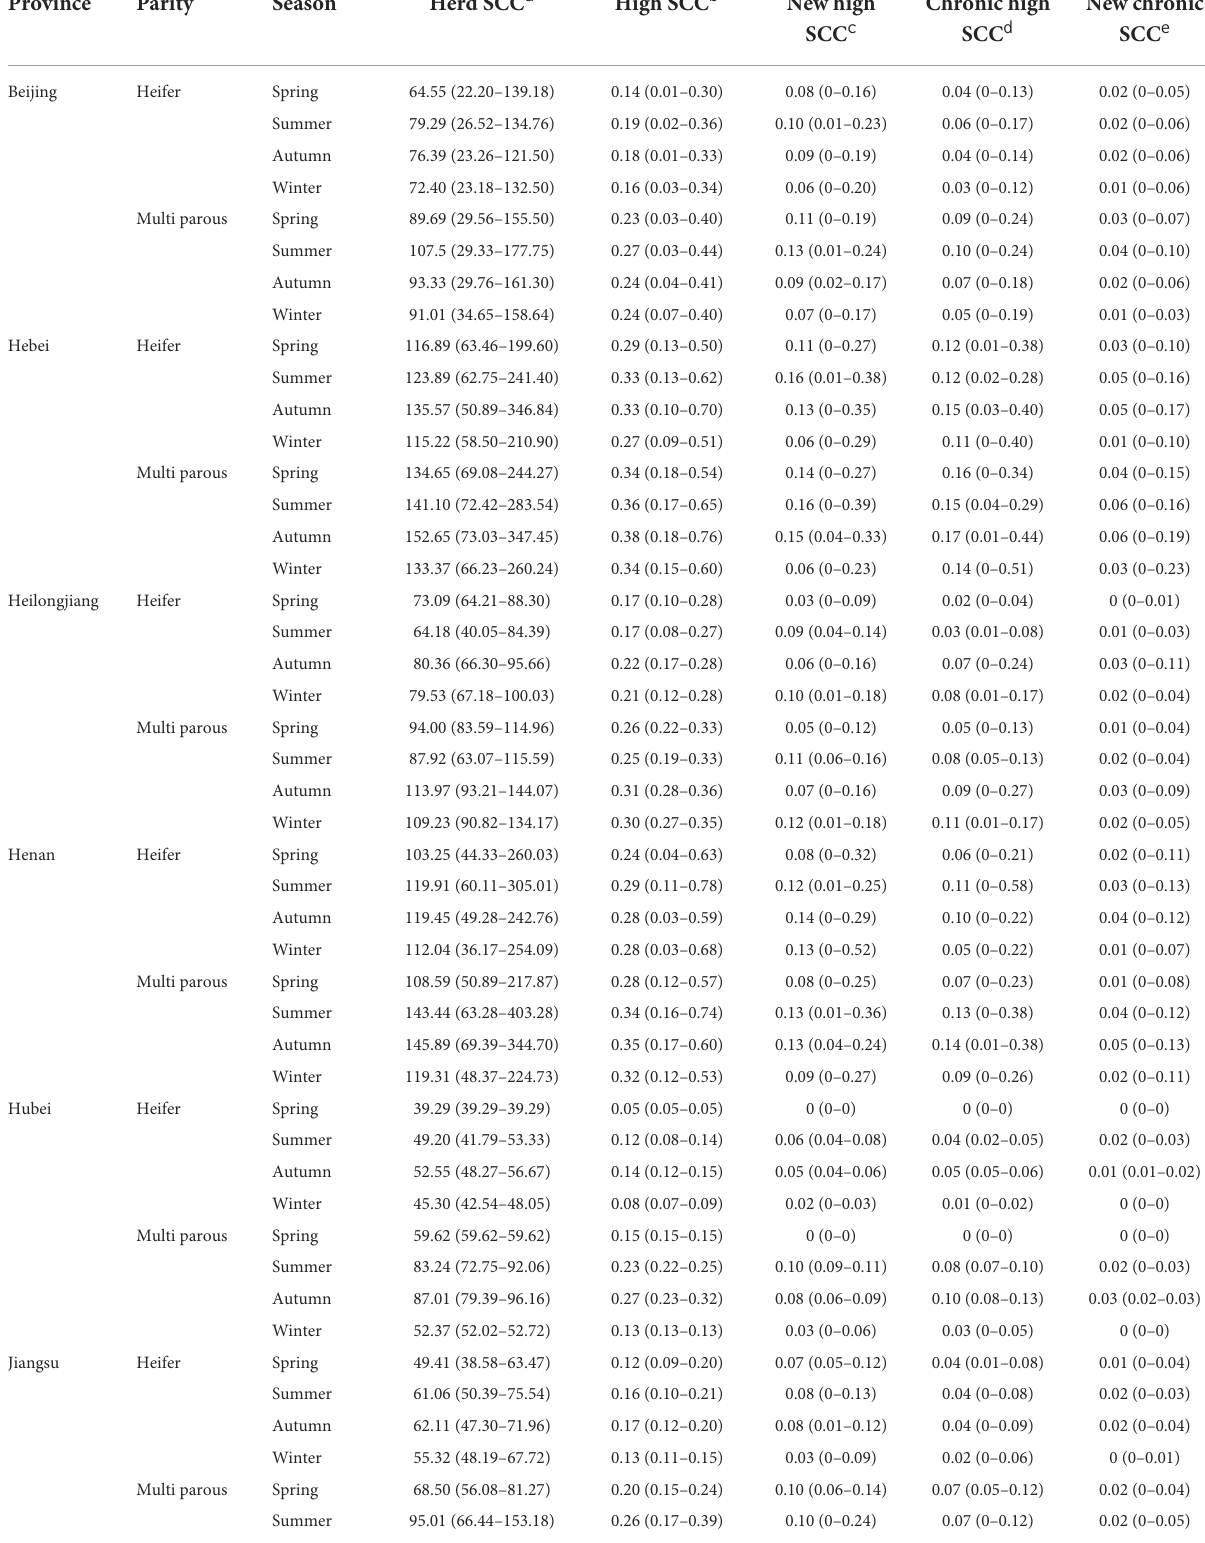
TABLE 2 Descriptive statistics of herd-level subclinical mastitis-related variables among 131 herds in 11 provinces in 2019.